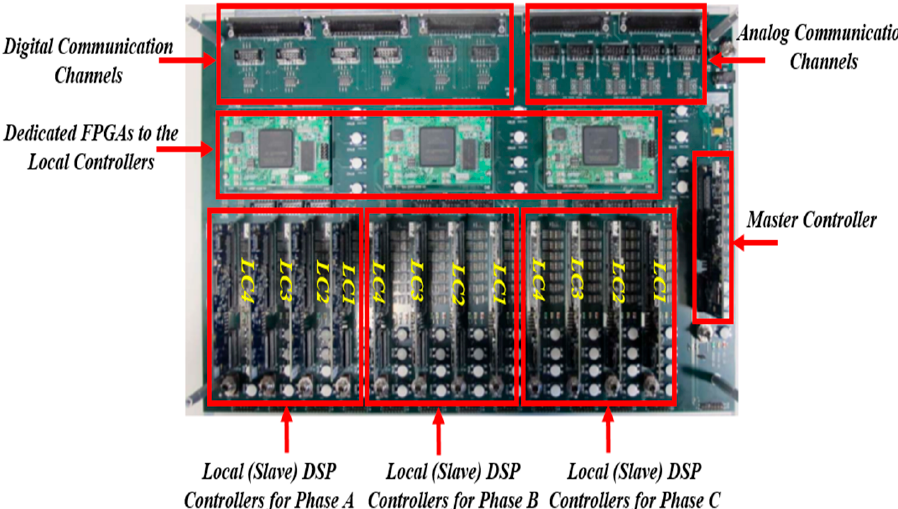
Figure 4. Modular distributed fault-tolerant controller.